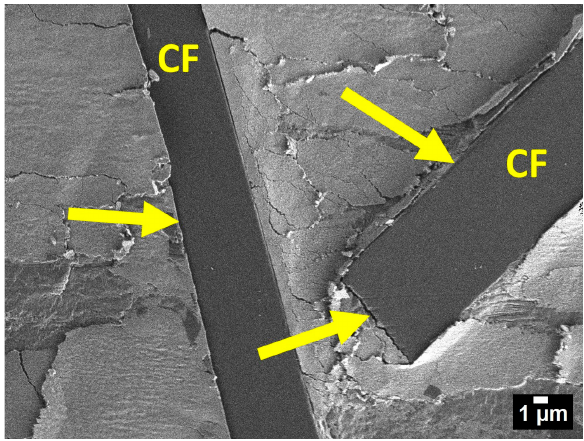
Figure 9. SEM image of worn surface PTFE/CF/ZrO 2 .